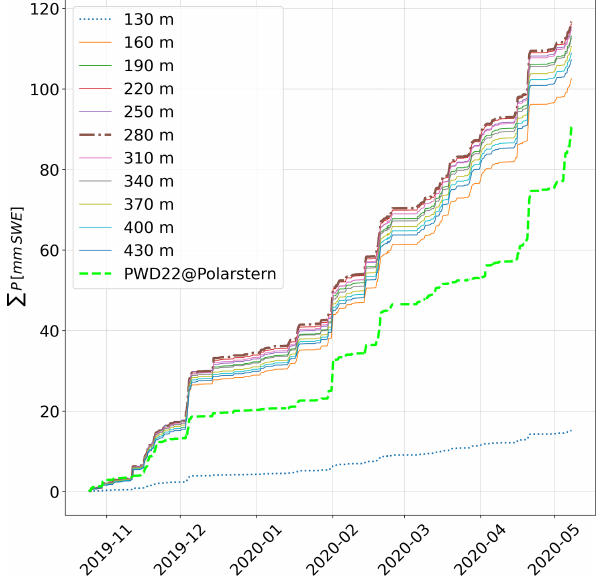
Figure 7. Computed cumulative snowfall for different KAZR range gates and